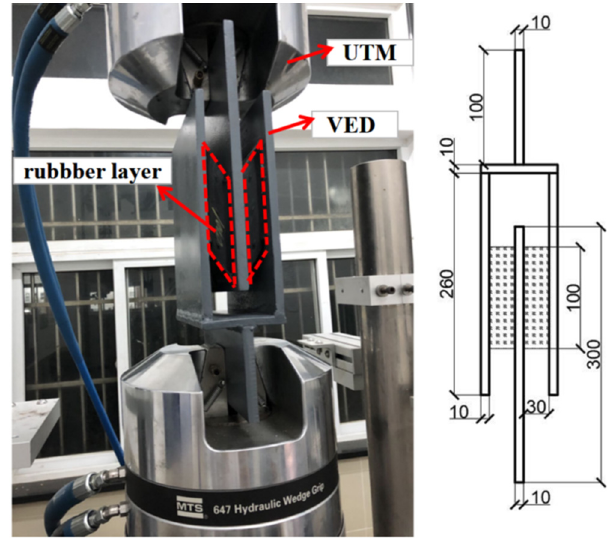
Figure 7. Test setup of viscoelastic material.